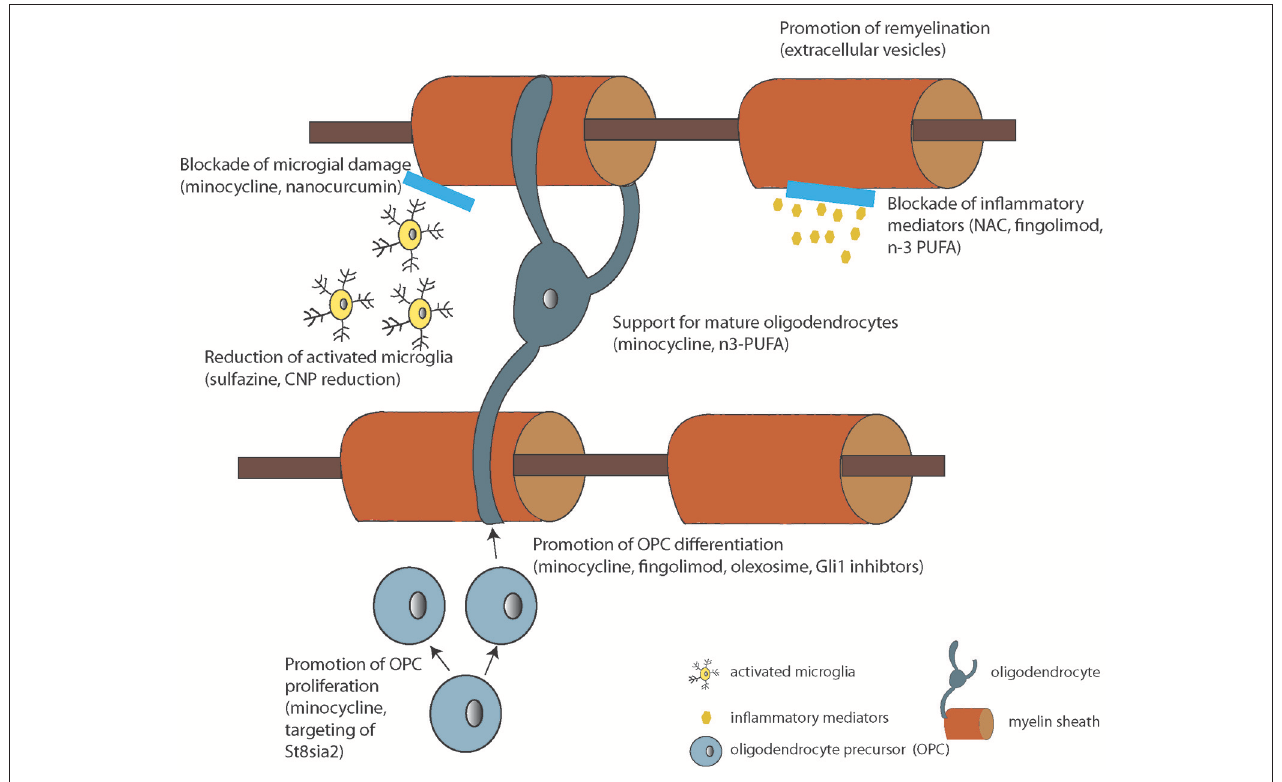
FIGURE 2 | Diagram summarizing the cellular or molecular mode of action of the compounds under development listed in Table 2 (where